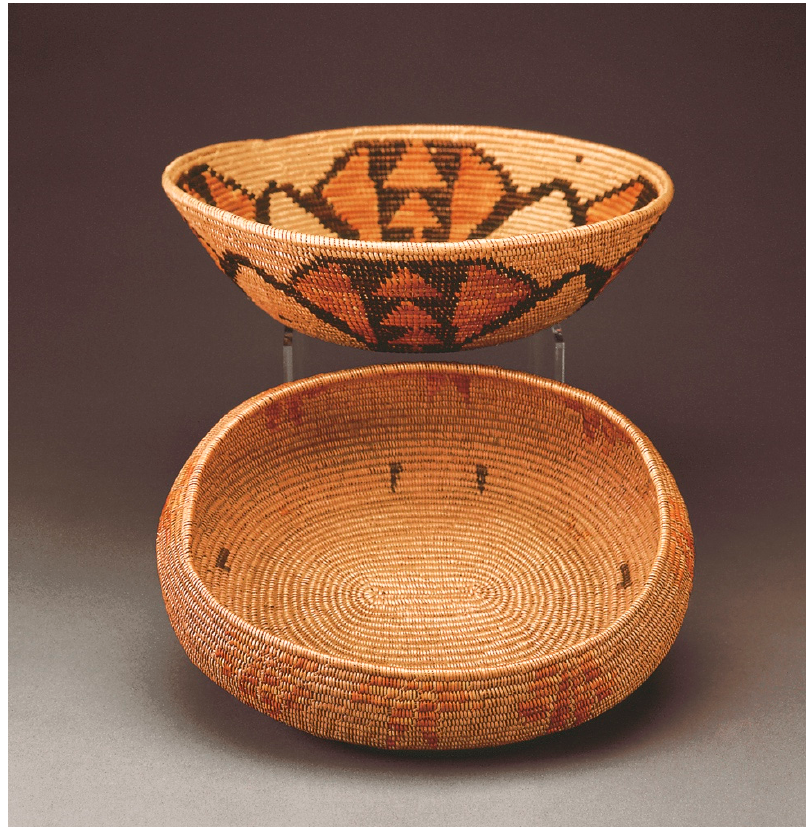
Figure 2. Bowl with Flower or Star, Anita Civé (Cupeño), 1900–1901, grasses, juncus, dyed juncus, diameter 11 ¼ and height 3 ¼ inches. Gift of Catherine Marshall Gardiner, Collection of the Lauren Rogers Museum of Art, Laurel, Mississippi, 23.112. ( Top ). Oval bowl, Ramona Valenzuela (Ipai), before 1923, grass, three-leaf sumac, rush, 3 ¼ × 9 × 10 ½ inches. Gift of Catherine Marshall Gardiner, Collection of the Lauren Rogers Museum of Art, Laurel, Mississippi, 23.88. ( Bottom ). (Used by permission of the Lauren Rogers Museum of Art)